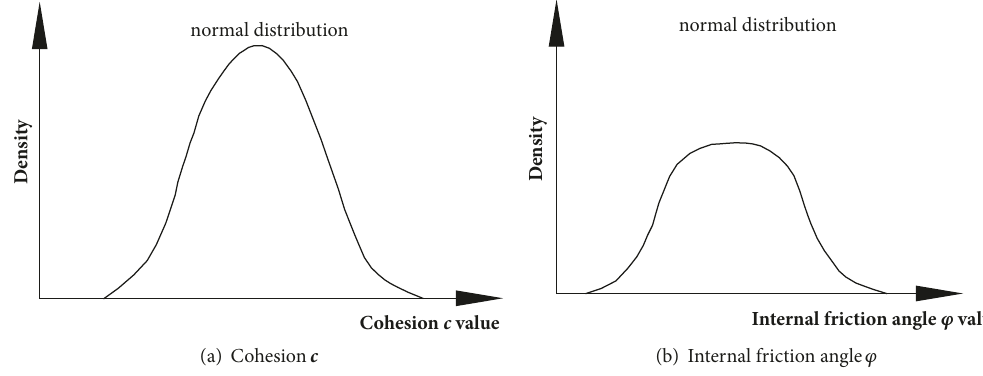
Figure 7: Typical probability density functions of shear strength